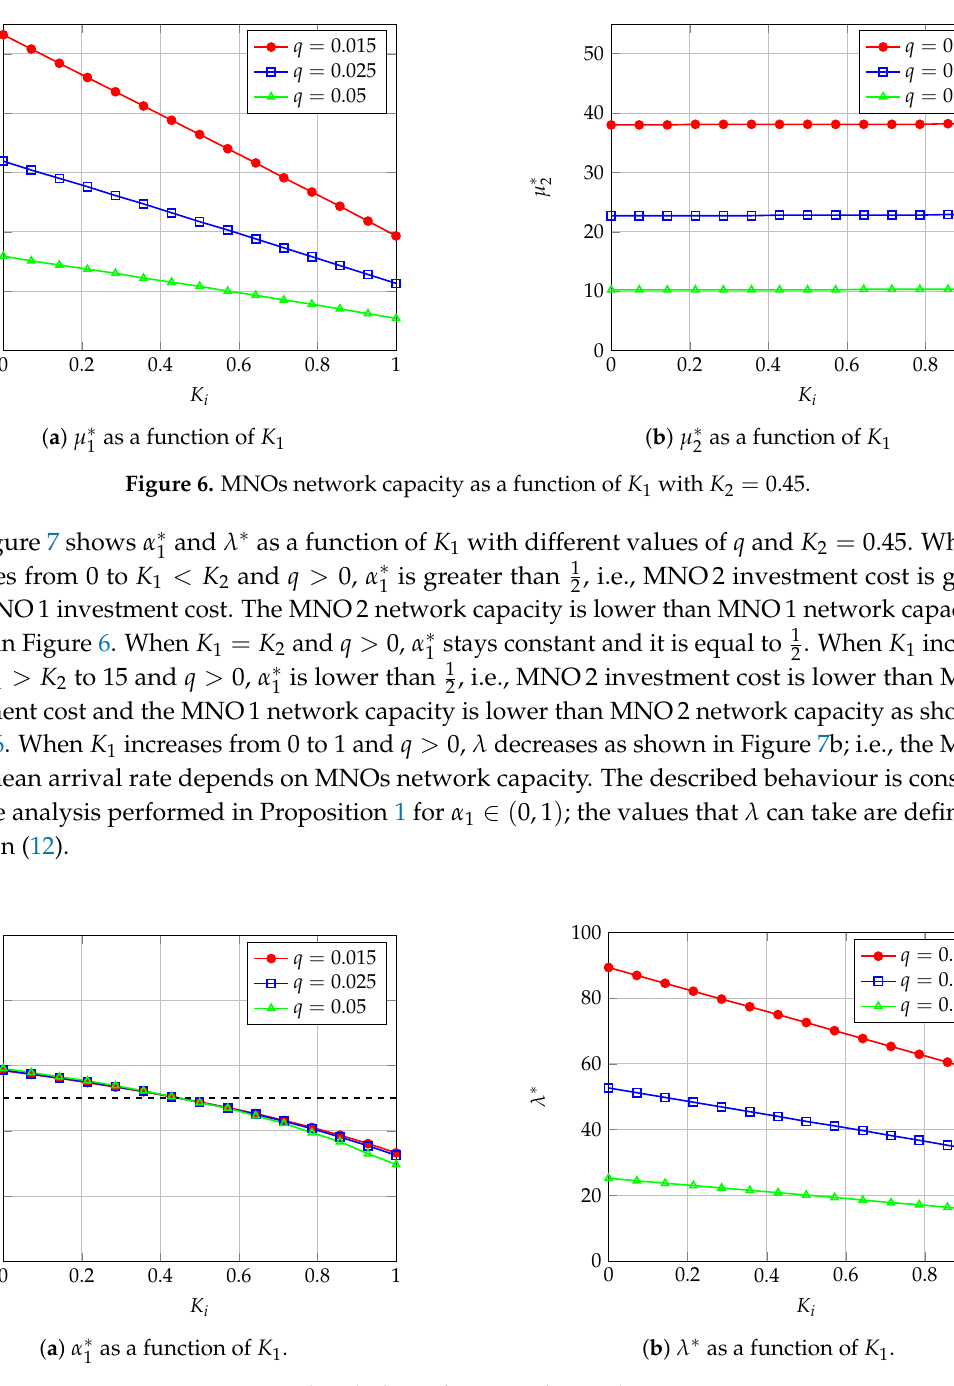
Figure 7. α ∗ and λ ∗ as a function of K 1 with K 2 = 1